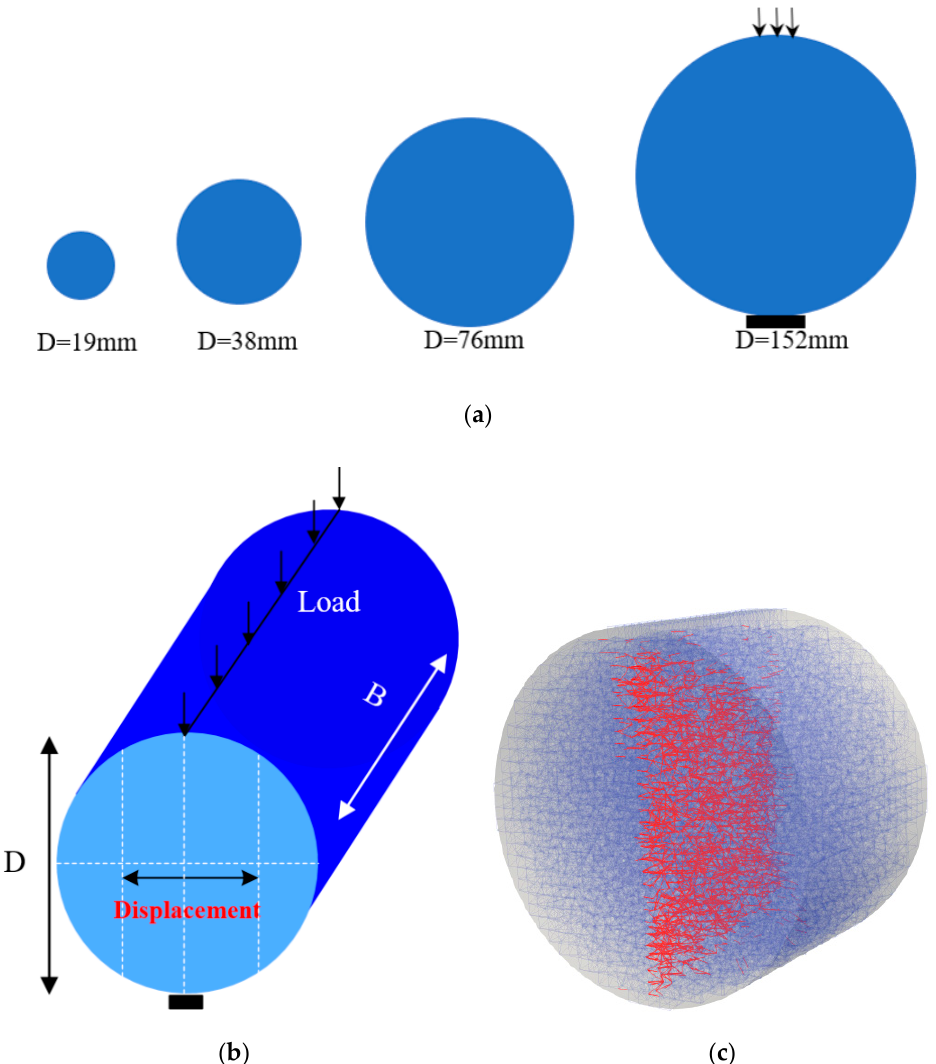
Figure 7. ( a ) Setup for tensile splitting test, ( b ) failure mode for splitting tensile test, ( c ) crack patterns for splitting tensile test (red-cracked element). Table 5. Values of input parameters in the numerical analyses about the tensile splitting test.